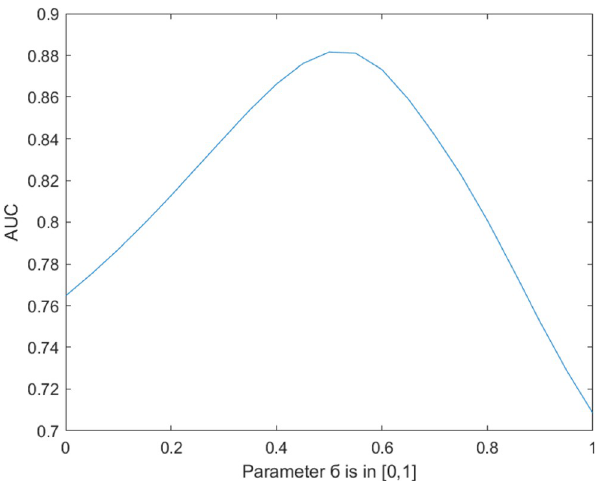
Fig 5. Influence curve of parameter a on AUC within